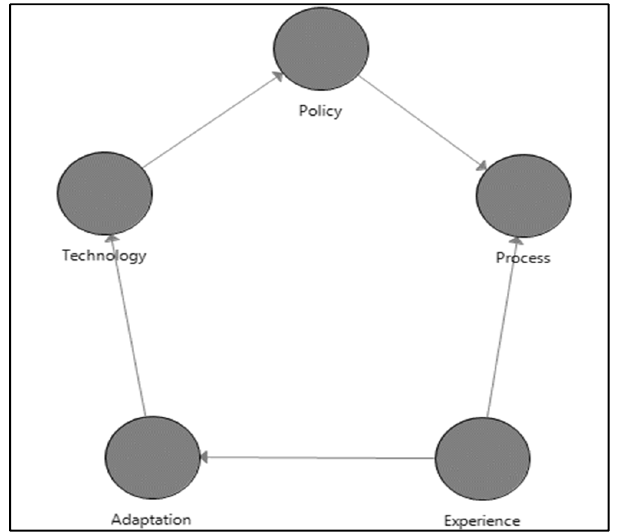
Figure 3. Interrelationships of parameters to characterize BIM users.